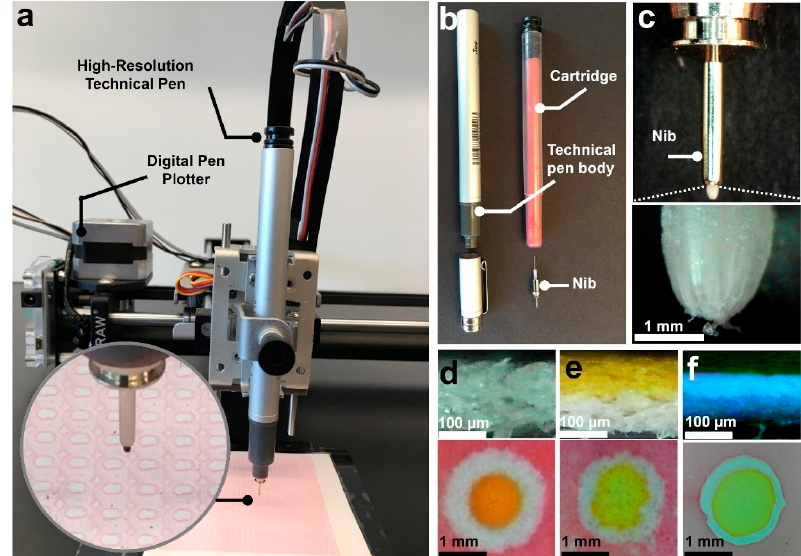
Figure 1. High-resolution fabrication of multiplex paper-based microfluidic devices using a pen plotter machine and high-resolution technical pens. ( a ) Desktop pen plotter with a high-resolution technical pen. ( b ) High-resolution technical pen with 0.1 mm plastic tip used for patterning hydrophobic solution to create detection zones. ( c ) Technical pen nib with 0.1 mm plastic tip used for patterning hydrophobic solution on paper substrate. ( d , e ) Cross-section of chromatography paper ( d ), chromatography paper after being coated with hydrophobic solution using the wide marker ( e ), regenerated paper ( f ), and corresponding circular pattern (2 mm diameter) on those paper substrates. The yellow food dye is applied to the hydrophilic side of paper to distinguish it from hydrophobic side.